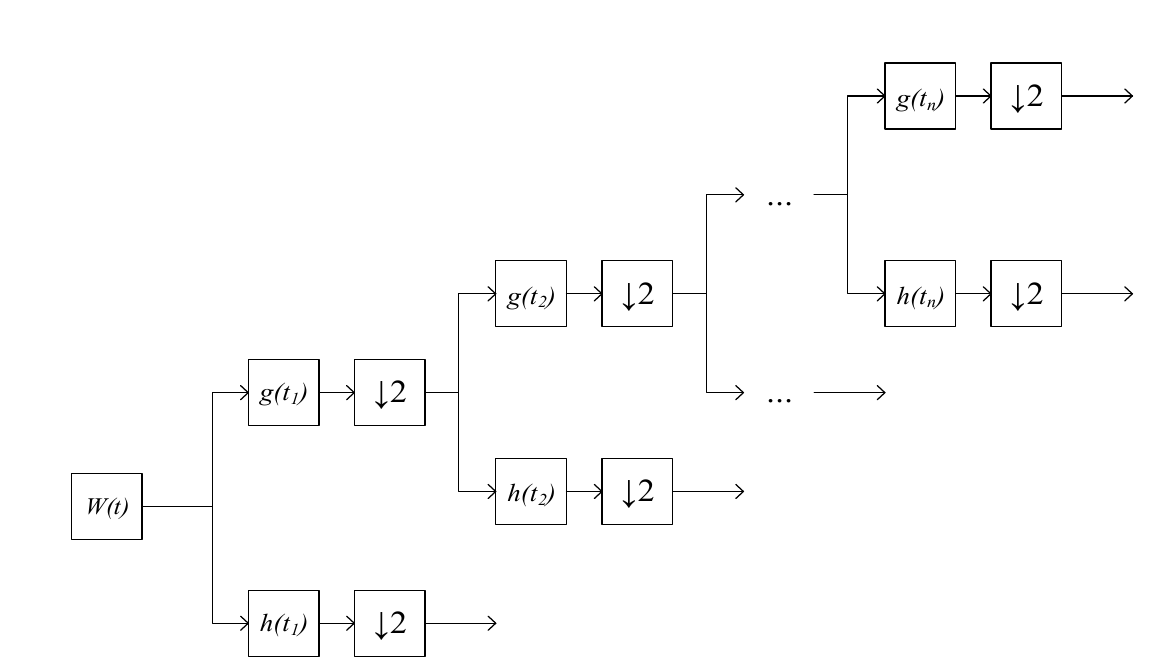
Figure 3. DWT ECG signal, where 𝑊(𝑡) is an ECG signal distorted by noise, 2 ↓ is a decimation, 𝑔 is a low-pass analysis filter, ℎ is a high-pass analysis filter.